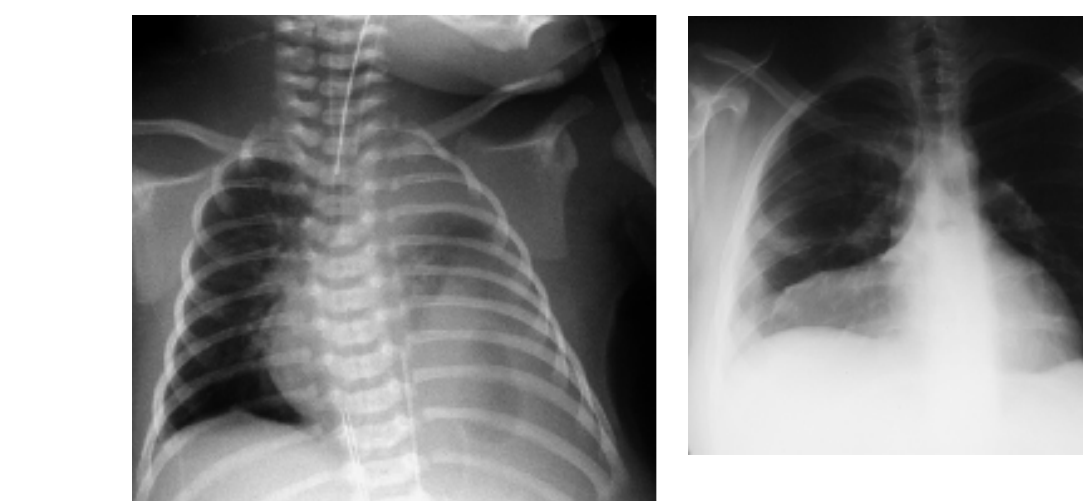
Congenital diaphragmatic hernia (CDH). Chest radiograph of a female newborn with the characteristic picture of left- sided posterolateral diaphragmatic hernia (Bochdalek) that had been diagnosed prenatally.